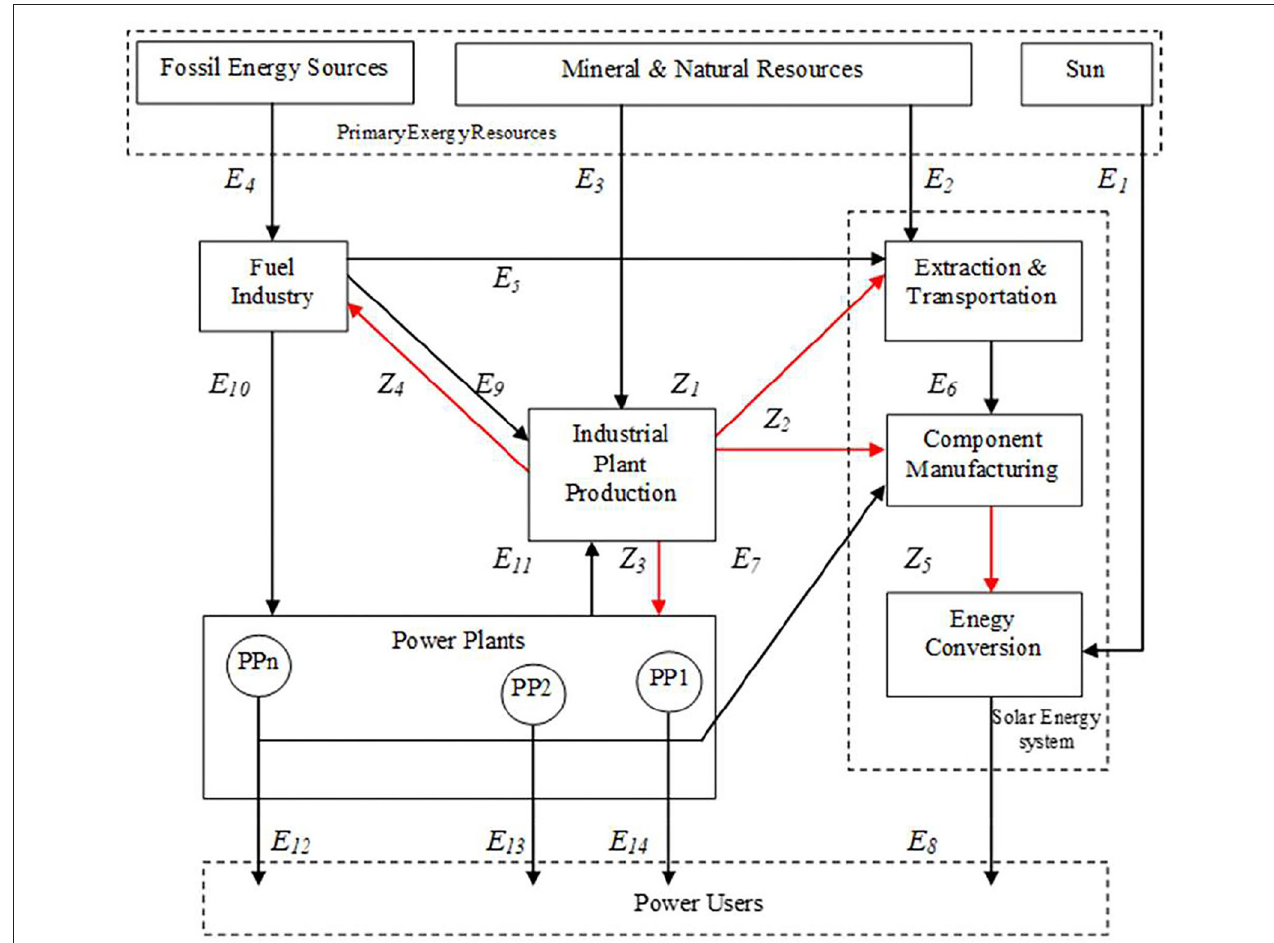
FIGURE 2 | The extended energy system for a solar energy production